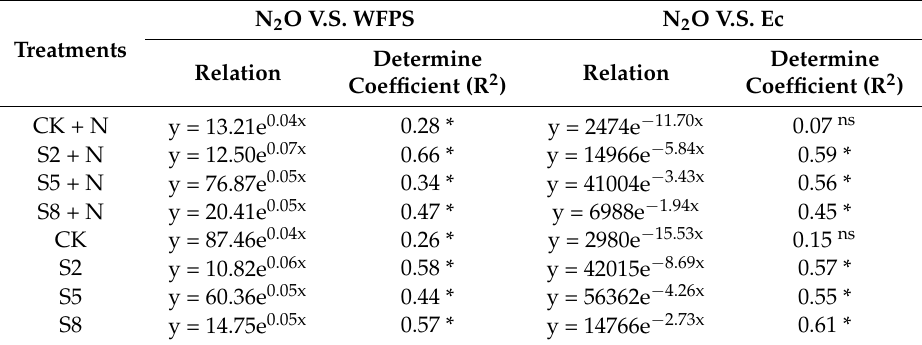
Table 3. The relationship of N 2 O emissions to soil moisture or salinity for each treatment.